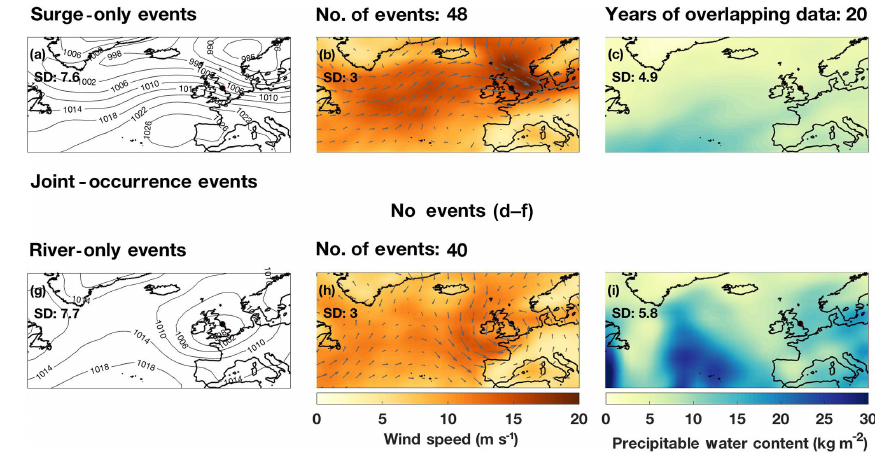
Figure 8. Meteorology conditions for Whitby [30]: (a, d, g) sea-level pressure (mbar), (b, e, h) wind speed (ms − 1 ) and direction (grey arrows), and (c, f, i) precipitable water content (kgm − 2 ) during (a, b, c) events with high skew surge only, (d, e, f) both high skew surge and high river discharge events, and (g, h, i) events with extreme events with high river discharge only. SD corresponds to the averaged standard deviation over the grid for each variable across the selected events.